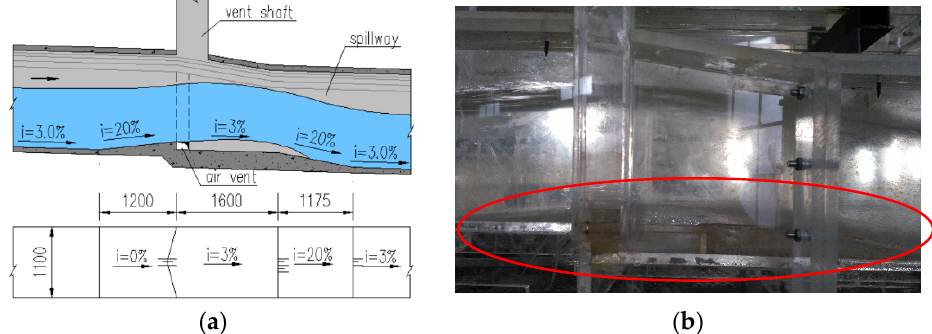
Figure 7. Group 11 shape design and flow pattern (Unit: cm): ( a ) the design aerator shape of Rumei; ( b ) flow pattern.